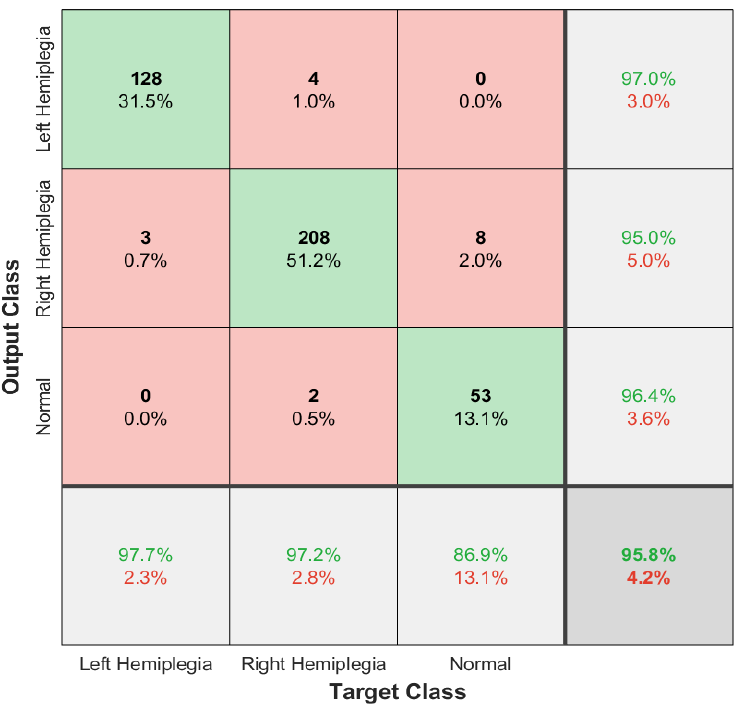
Figure 6. The confusion matrix. The green boxes show the correctly classified samples in this figure, while the red boxes show the misclassified ones. The vertical white boxes depict the percentages of all the samples predicted to belong to each class that is correctly (green color) and incorrectly (red color) classified. The horizontal white boxes depict the percentages of all the examples belonging to each class correctly (green color) and incorrectly (red color) classified. Finally, the grey box depicts the overall accuracy.